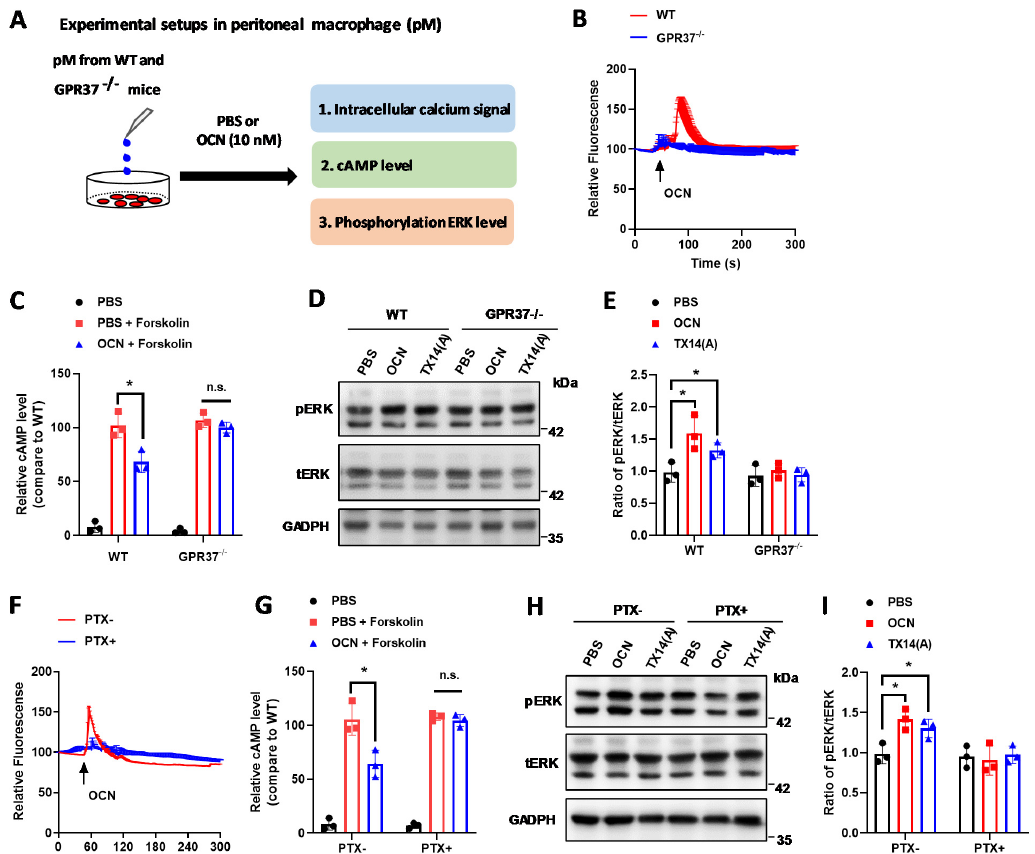
Figure 3. GPR37 mediates OCN-induced intracellular responses in macrophages. ( A ) Overview of the experimental design testing intracellular signals in macrophages. Peritoneal macrophages were isolated from WT and GPR37 − / − mice to study the changes of intracellular calcium level (iCa 2+ ), cAMP production, and pERK level in response to OCN treatment. ( B ) Representative response curves inhibition of cAMP production in macrophages from WT and GPR37 − / − mice. Data are